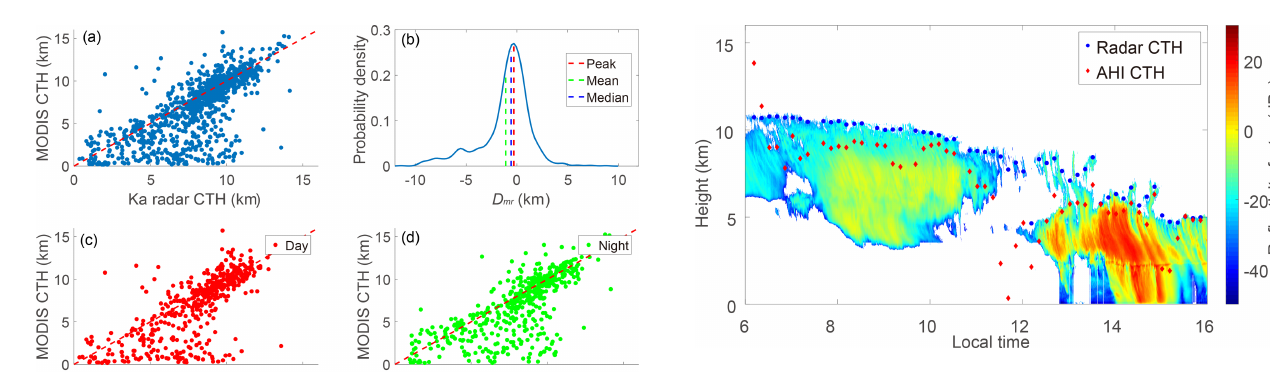
Figure 8. Examples of the Ka radar CTHs (blue dots) and the AHI CTHs (red diamonds) measured on 9 May 2016 from 06:00 to 16:00 (local time: UTC +